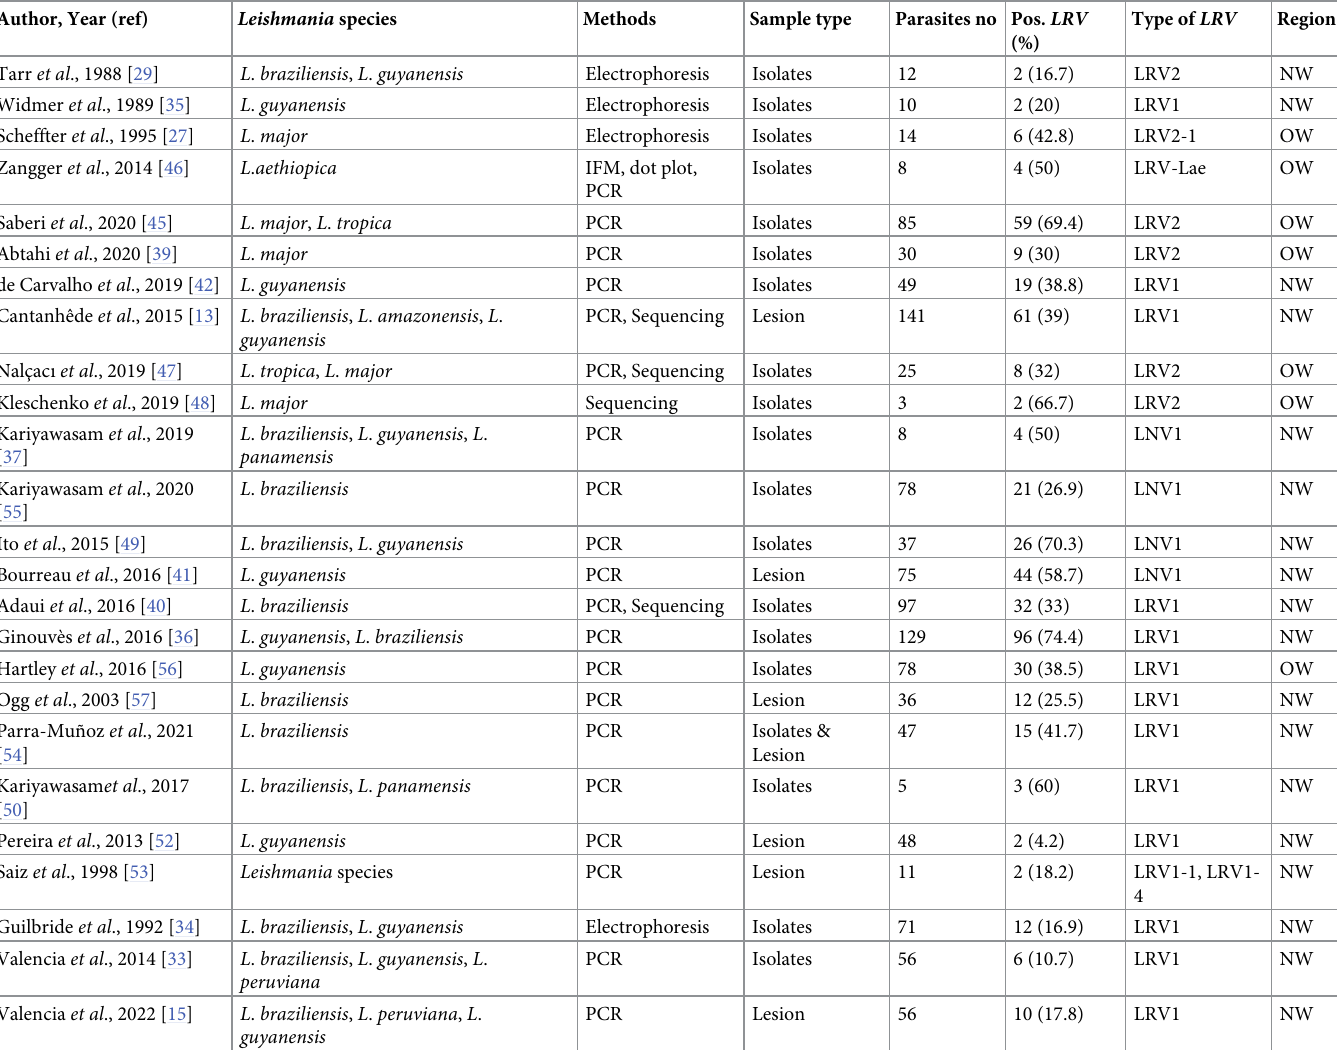
Table 1. Overview of the studies describing the presence of LRV in Leishmania parasites and/or lesions in patients with CL,